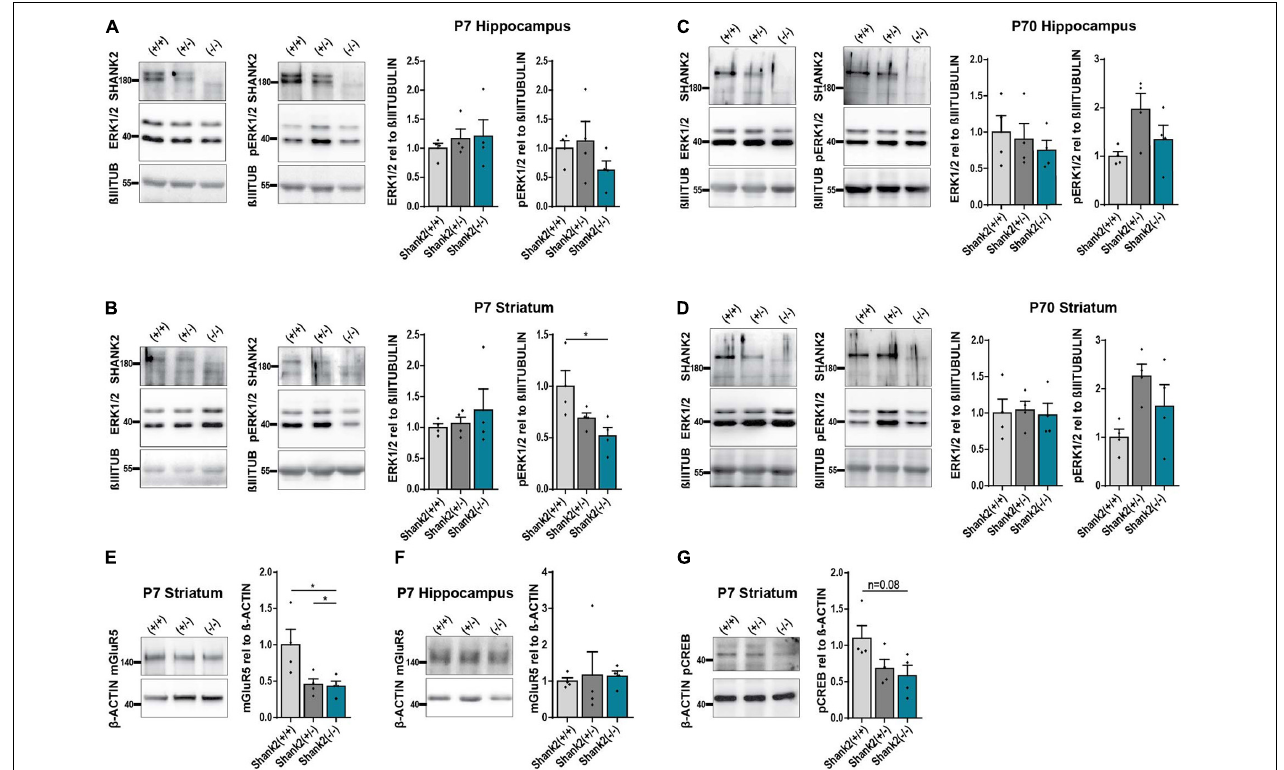
FIGURE 6 | The ERK1/2 signaling pathway is changed in striatum of P7 but not P70 Shank2 (–/–) mice. (A) SHANK2, ERK1/2, and phospho-ERK1/2 protein expressions relative to β -III-TUBULIN ( n = 4) in hippocampus of P7 Shank2 (+ / +) , Shank2 ( + / − ), and Shank2 ( –/– ) mice. (B) SHANK2, ERK1/2, and phospho-ERK1/2 protein expressions relative to β -III-TUBULIN ( n = 4) in striatum of P7 Shank2 (+/+) , Shank2 ( + / − ), and Shank2 (–/–) mice. (C) SHANK2, ERK1/2, and phospho-ERK1/2 protein expressions relative to β -III-TUBULIN ( n = 4) in hippocampus of P70 Shank2 (+/+) , Shank2 ( + / − ), and Shank2 (–/–) mice. (D) SHANK2, ERK1/2, and phospho-ERK1/2 protein expressions relative to β -III-TUBULIN ( n = 4) in striatum of P70 Shank2 (+/+) , Shank2 ( + / − ), and Shank2 (–/–) mice. (E) mGluR5 protein expression relative to β -ACTIN ( n = 4) in striatum of P7 Shank2 (+/+) , Shank2 ( + / − ), and Shank2 (–/–) mice. (F) mGluR5 protein expression relative to β -ACTIN ( n = 4) in hippocampus of P7 Shank2 (+/+) , Shank2 ( + / − ), and Shank2 (–/–) mice. (G) phospho-CREB protein expression relative to β -ACTIN ( n = 4) in striatum of P7 Shank2 (+/+) , Shank2 ( + / − ), and Shank2 (–/–) mice. β IIITUB: β -III-TUBULIN. Data were normalized to mean of Shank2 (+/+). Mean ± SEM, one-way ANOVA, followed by Tukey’s post hoc analysis. Significance levels were set to * p ≤